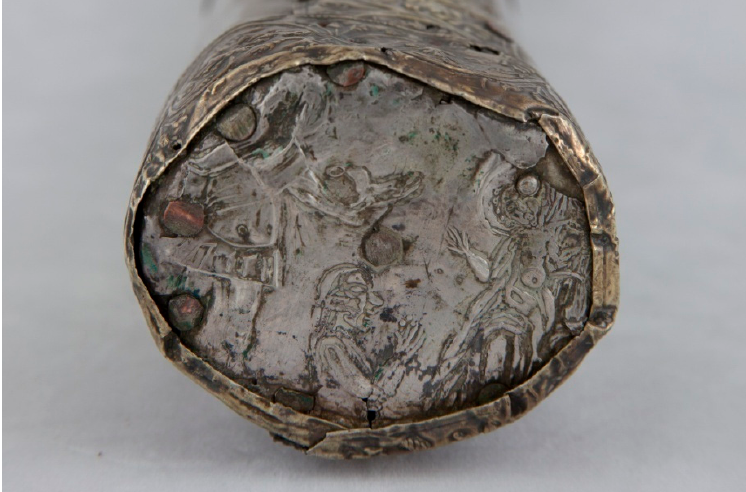
Figure 9. Bottom of an arm-shaped reliquary (15th century) with ex-voto (18th century), Cathedral of Saint Tryphon, Kotor, photo by Stevan Kordi ć .